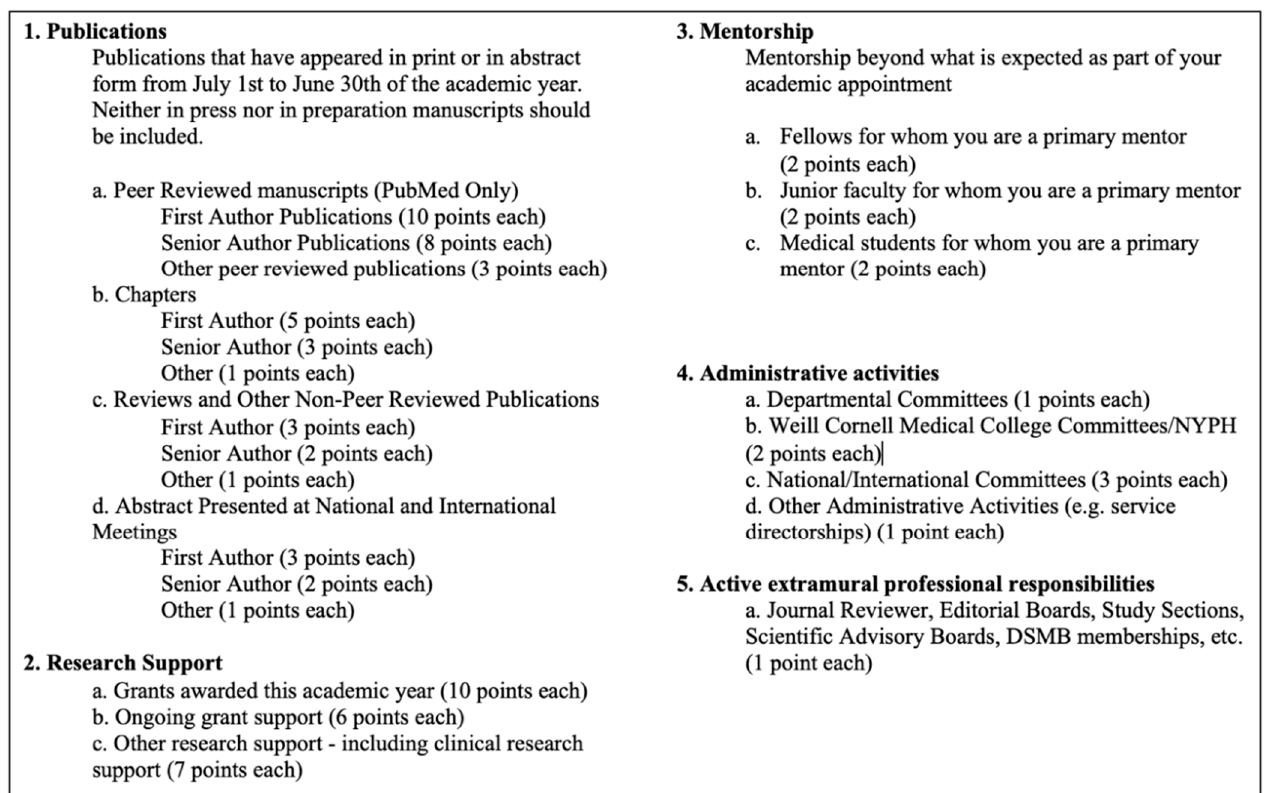
Figure 1. Breakdown of points awarded.